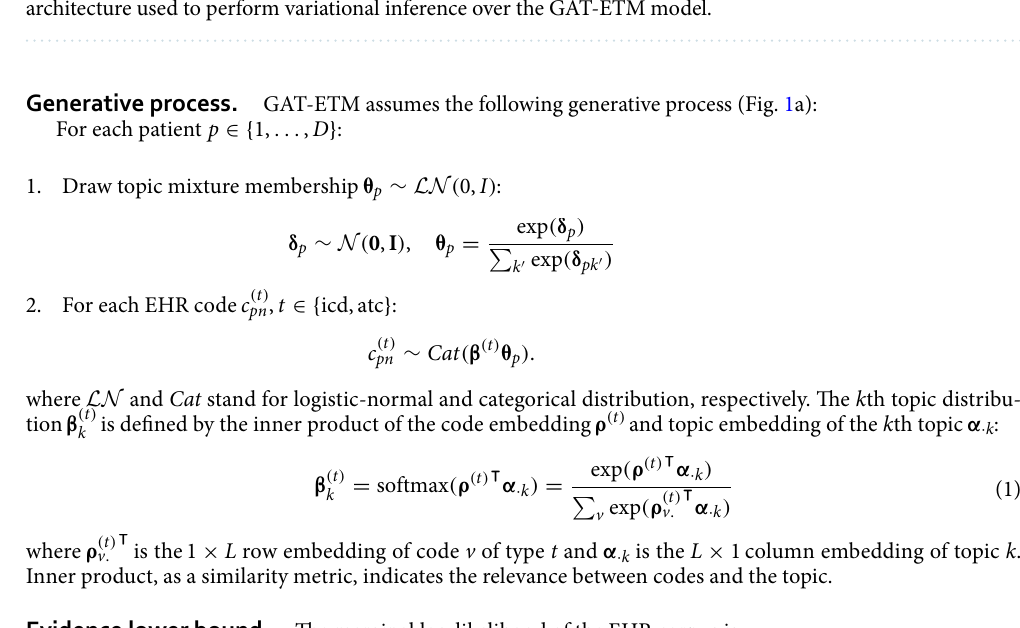
Figure 1. GAT-ETM model overview. ( a ) The probabilistic graphical model view of GAT-ETM. ( b ) The augmentation and merger applied on the taxonomy knowledge graphs. ( c ) The illustration of the deep learning architecture used to perform variational inference over the GAT-ETM